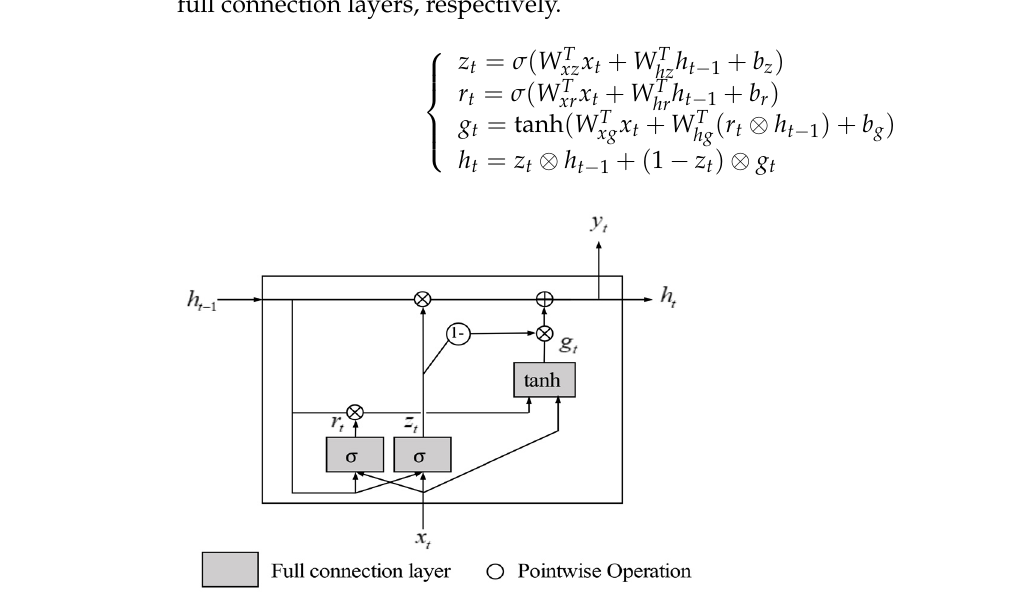
the forward direction) and h (cid:48) (output in the reverse direction). The second layer and the j third layer are the same unidirectional GRU network. The fourth layer outputs y i m last time step and inputs it to two full connection layers. Finally, the network outputs a 4-dimensional vector, and the value (between 0 and 1) of each dimension in this vector represents the probability that TS i m n belongs to a certain class of ships.